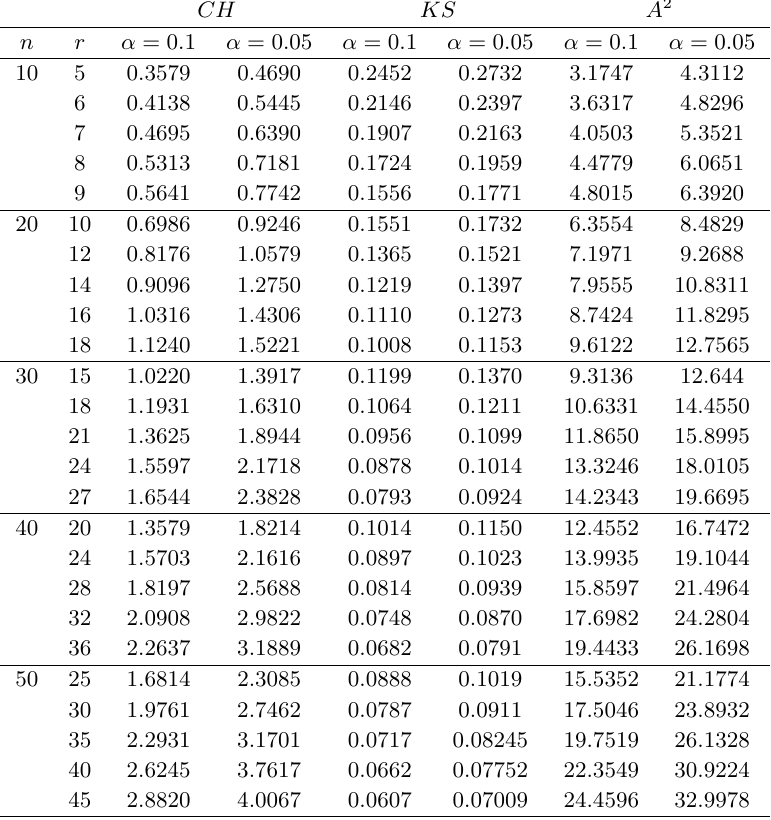
Critical points of the test